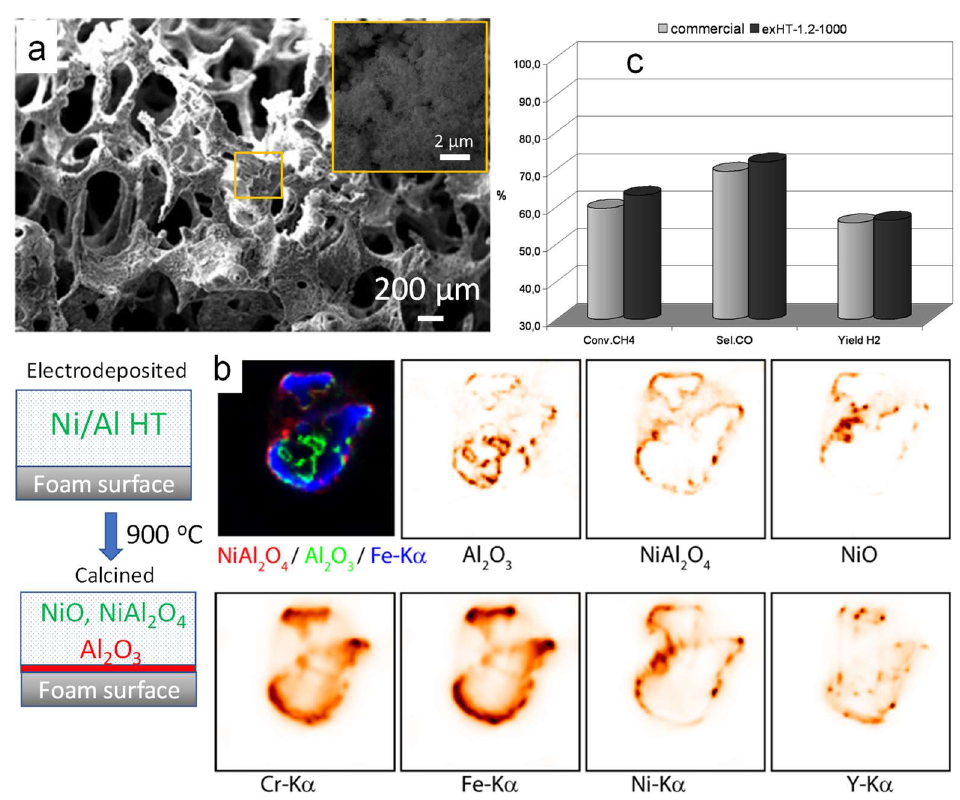
Figure 5. Properties and catalytic activity of Ni/Al HT-derived catalysts coated on FeCrAlloy foam at −1.2 V vs. SCE for 1000 s and calcined at 900 °C for 12 h. ( a ) SEM images, ( b ) µ-XRF/XRD tomography images: elemental (lower row) and phase (upper row) maps obtained by XRF/XRPD tomography [240 µm (3 µm steps) × 180° (2° steps)]. Identification by comparison with the ICDD PDF-2 database yields: Al 2 O 3 (75–1862), NiAl 2 O 4 (73–0239) and NiO (89–7390), ( c ) Catalytic activity for SR of CH 4 at P = 20 bar, S/C = 1.7, T oven = 900 °C, contact time τ = 4 s. Figure 5a was adapted from [62], Figure 5b from [66] and Figure 5c from